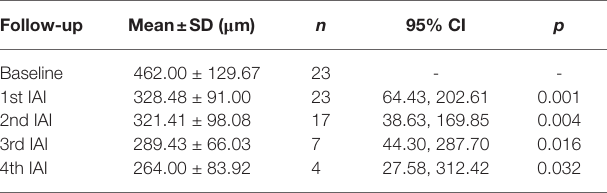
TABLE 3 | CMT values before and after IAI in patients with DME.